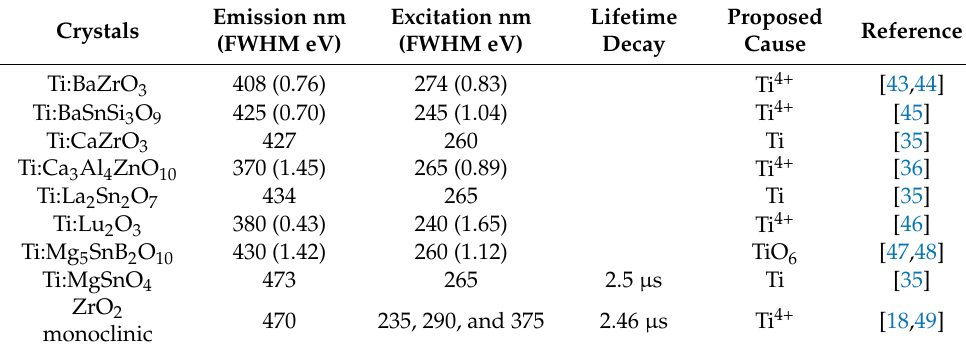
Table 4. Summary of luminescent properties of synthetic compounds containing extrinsic Ti for which BSL has been documented. For all, the perceived luminescence color is